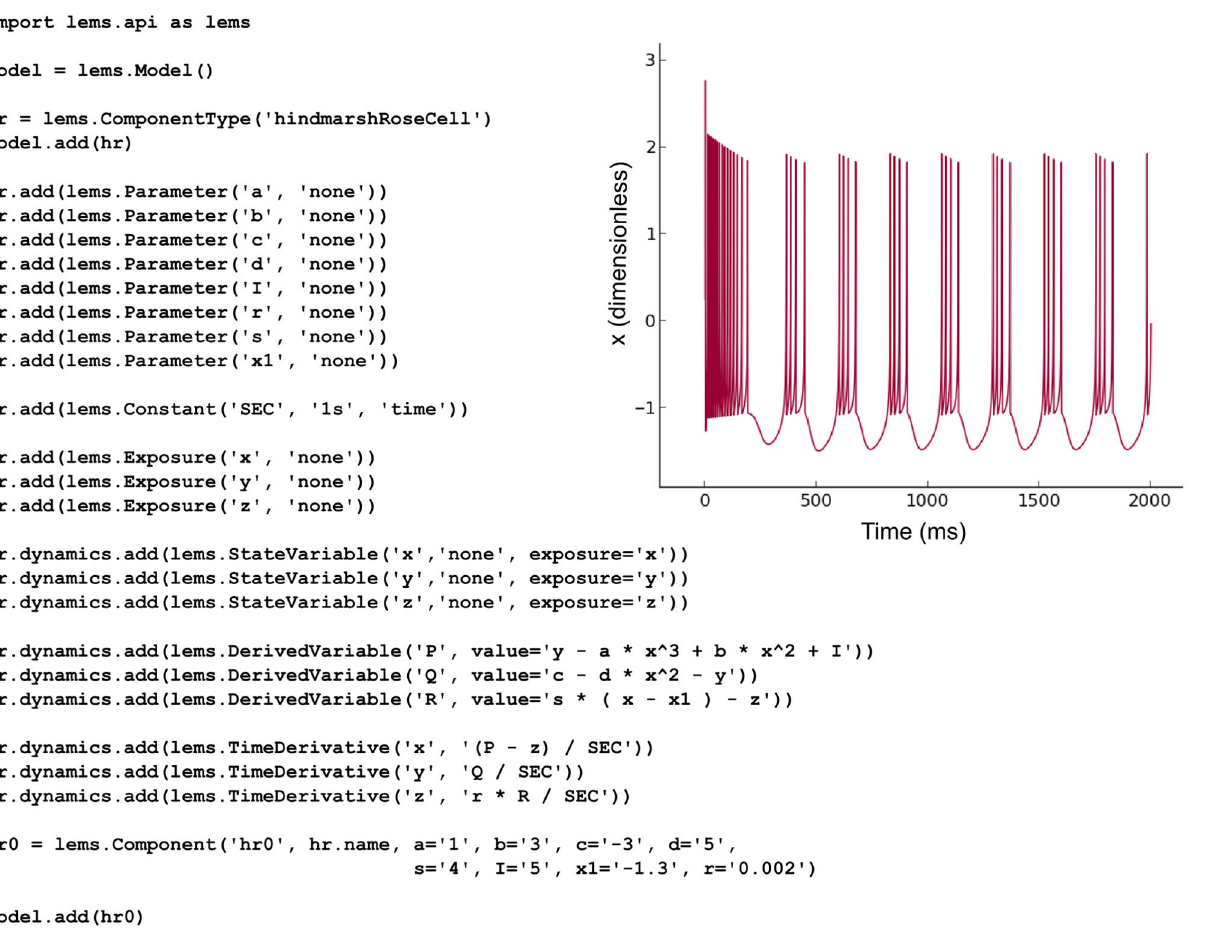
Figure 9 | The Hindmarsh and Rose spiking neuron model. A LEMS ComponentType for this model is built adding the three state variables (x, y, z) and the eight fixed parameters required for instances of the model. Time derivatives for the state variables are specified using derived variables to shorten the required expressions. One Component